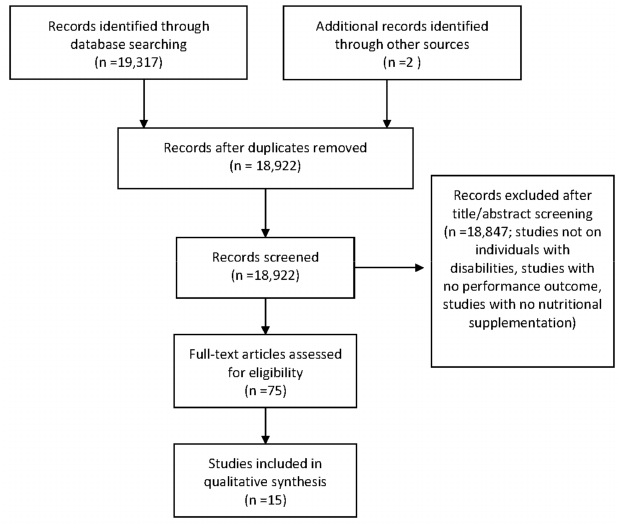
Figure 1. PRISMA diagram: Flow chart of study section